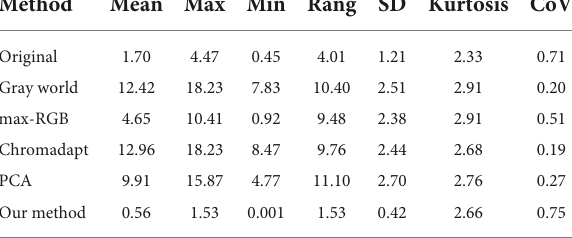
TABLE 3 Comparison of the color cast correction accuracy in terms of CIEDE2000 calculated with the reference mineral green pigments.